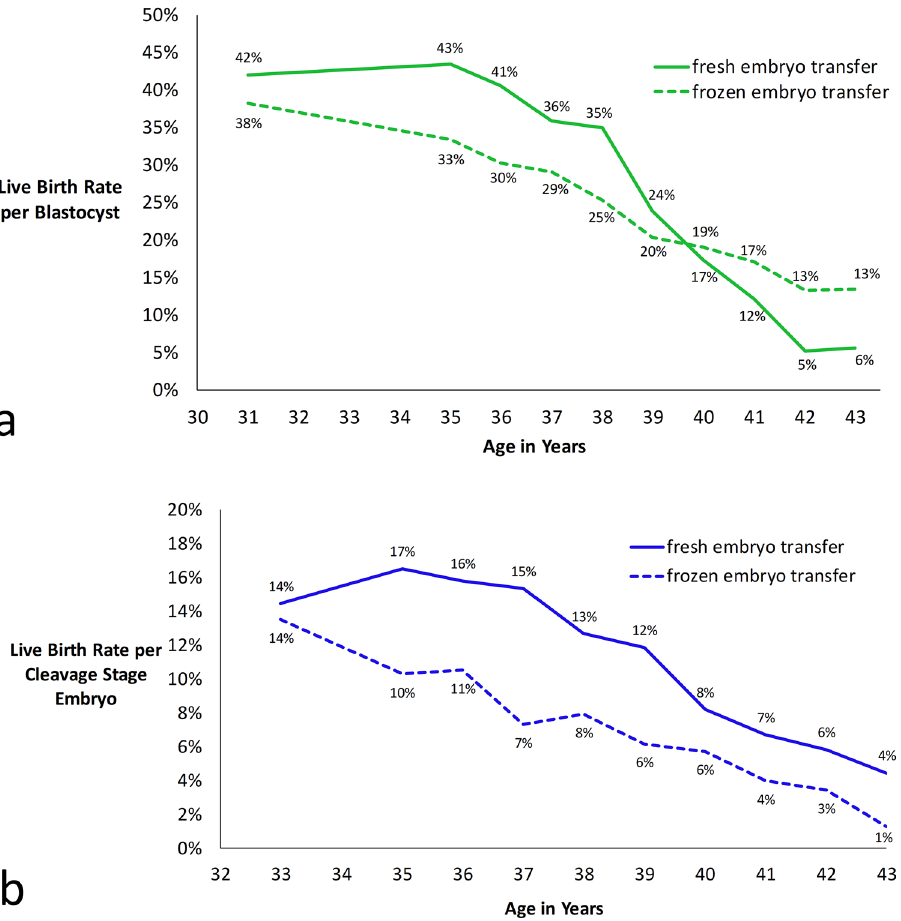
Figure 3. Live Birth Rate per Embryo for ( a ) Blastocyst and ( b ) Cleavage Stage Embryos. 5-year moving groups are used to calculate live birth rates for ages 35 to